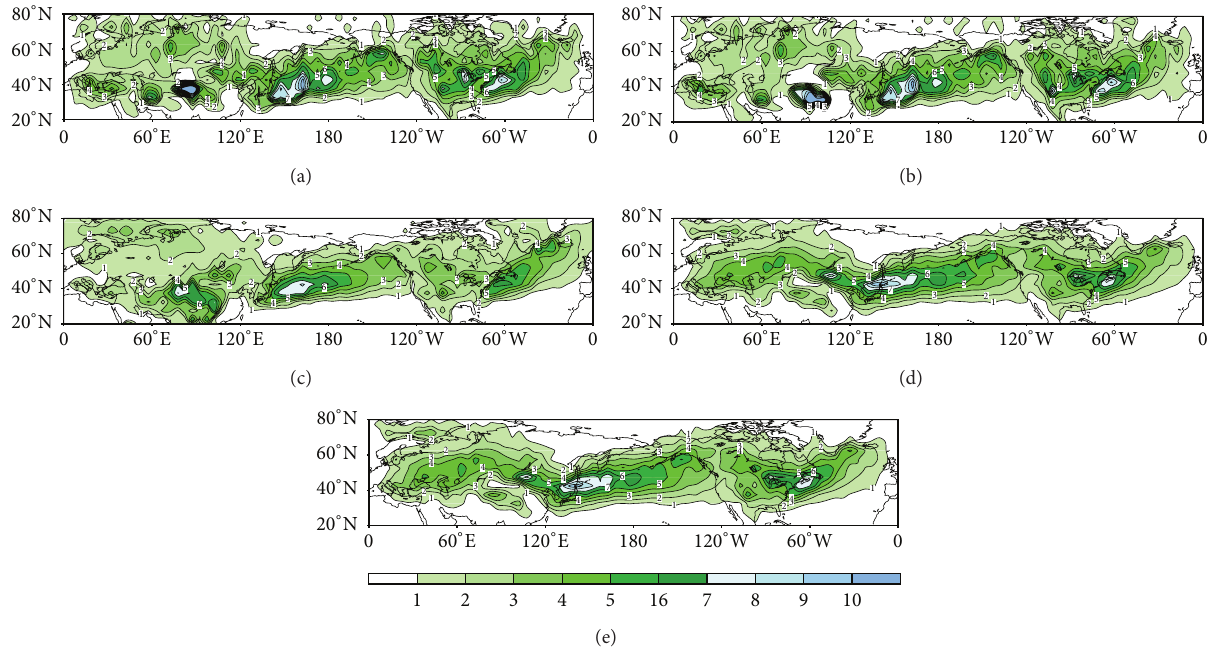
Figure 1: NH JFM storm track frequency climatology for (a) NCEP1, (b) ERA40, (c) CFSR, (d) CMIP1, and (e) CMIP2.